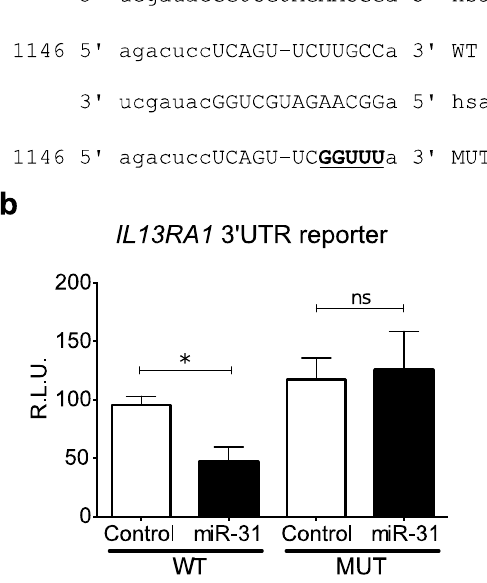
Figure 3. MicroRNA-31 directly binds and targets the 3 ′ UTR of IL13RA1 mRNA: ( a ) Schematic depicting the predicted binding site for miR-31 in the 3 ′ UTR of IL13RA1 mRNA (WT) and the generated mutant version (MUT); and ( b ) Bar graph showing the effects of over expressing miR-31 on the enzymatic activity of the Luciferase reporter generated for the predicted binding site and its mutant version. Co-transfection of miR-31 with the WT and MUT reporters in HeLa cells determined that miR-31 was able to significantly decrease the activity in the WT reporter only. Statistics were done employing a paired two-tailed t -test. Represented are mean + standard error of the mean R.L.U.: Relative luminescence units. *: p -value ≤ 0.05.